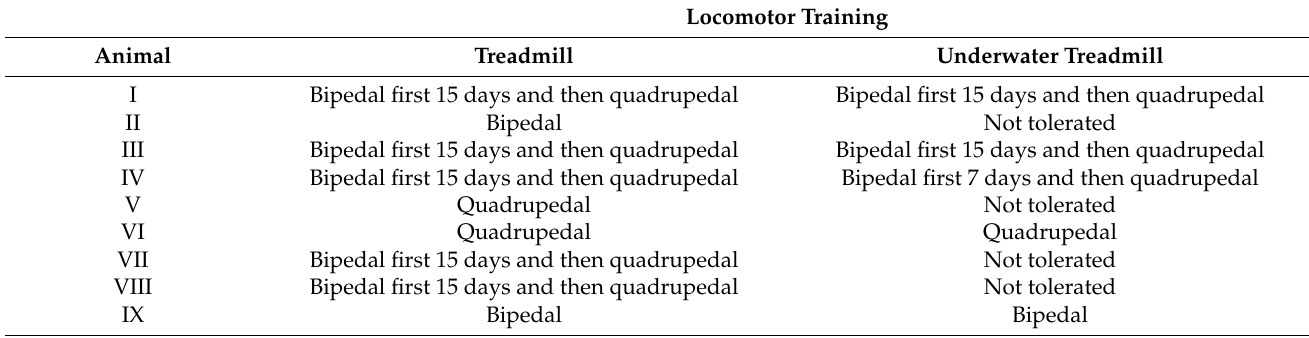
Table 1. Locomotor training performed by the cats. Locomotor